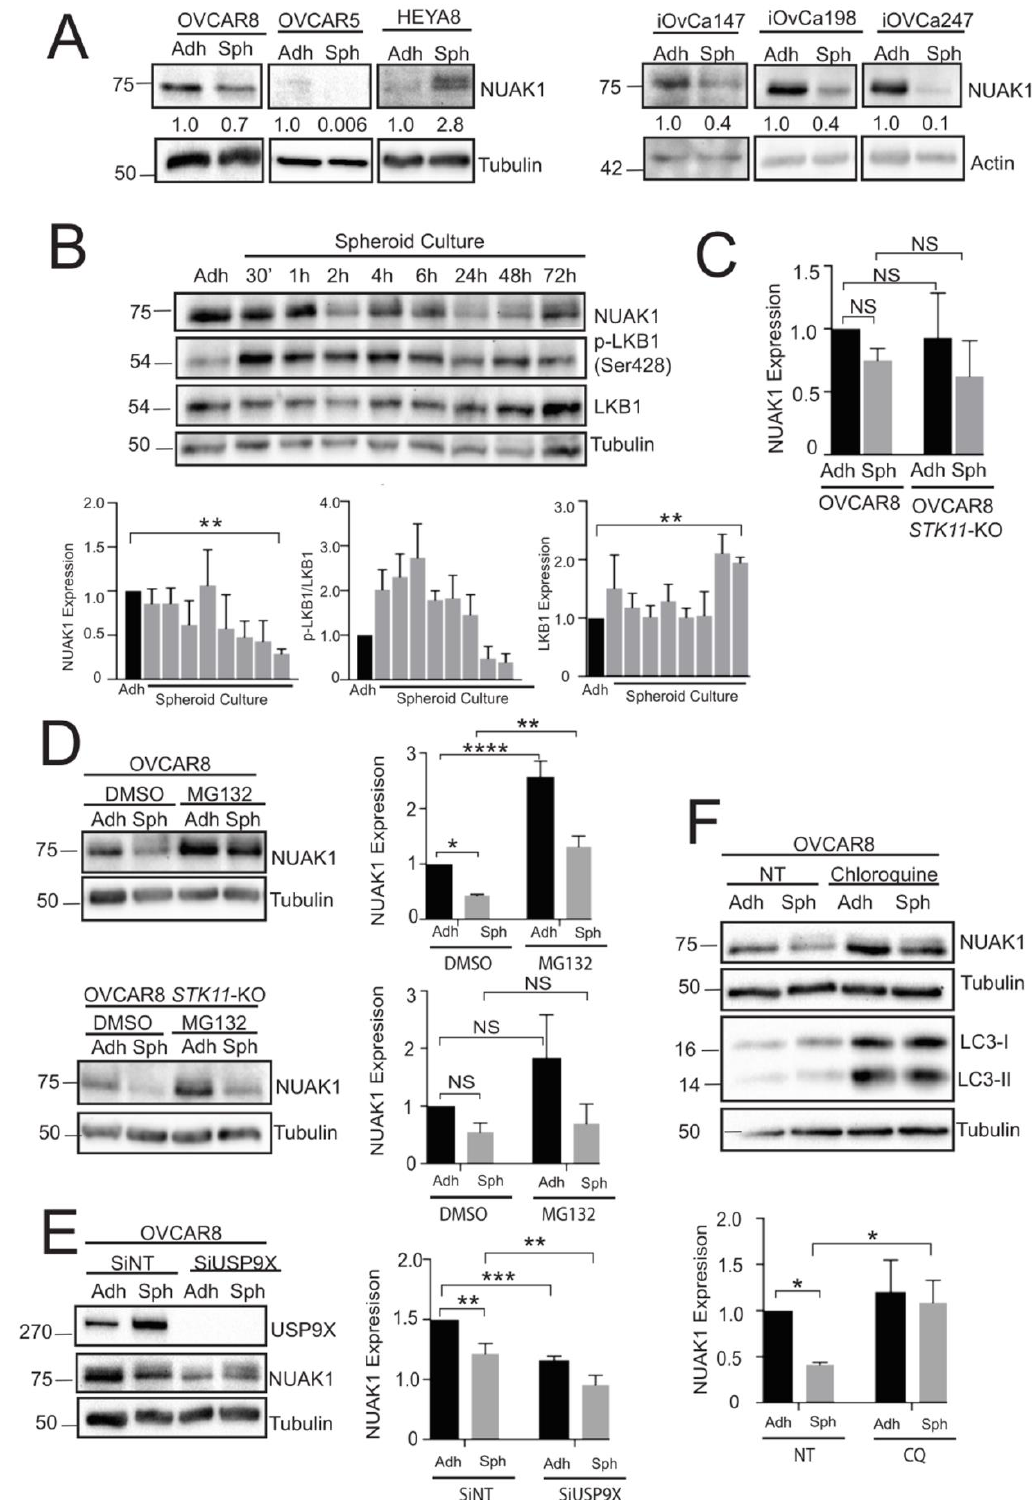
Figure 2. Regulation of NUAK1 expression and stability in EOC spheroids. ( A ) Immunoblot analysis to assess NUAK1 expression in HGSOC cell lines (OVCAR8, OVCAR5), a non-HGSOC cell line (HEYA8), and patient-derived ascites cell lines (iOvCa147, iOvCa198, iOvCa247) cultured under adherent (Adh) or suspension (Sph) conditions. Tubulin and actin were used as loading controls. Fold change in NUAK1 expression relative to adherent cells is indicated. Whole blot images can be found in Figures S9–S18. ( B ) Time course analysis of NUAK, phospho-LKB1 (S428), and total LKB1